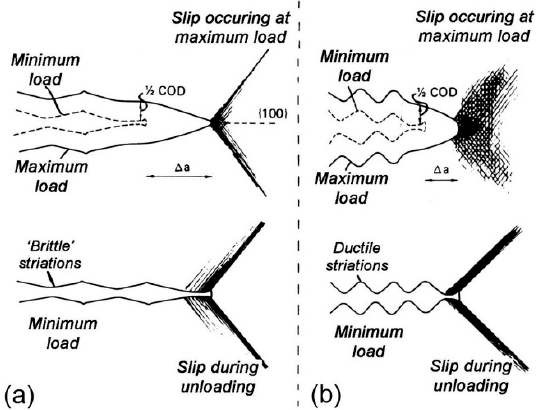
Figure 10. Crack propagation mechanism in a liquid environment [8]. ( a ) Liquid-metal environment producing brittle striations; ( b ) inert environments producing ductile striations.